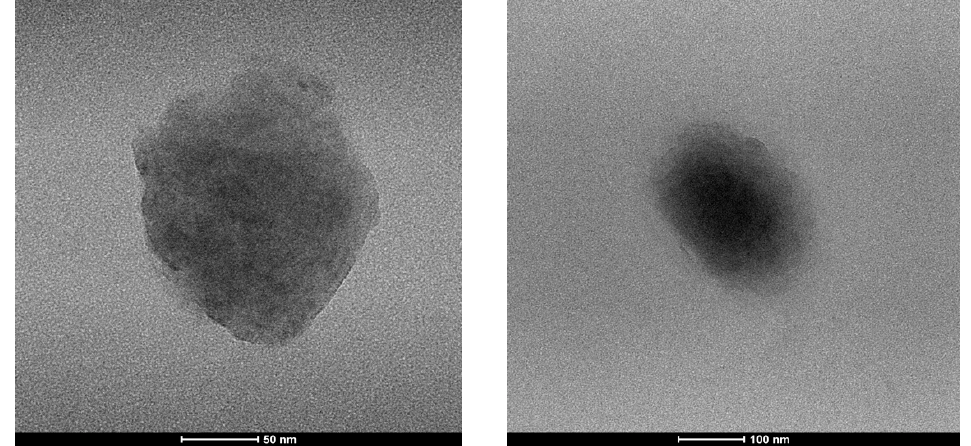
Figure 3. Morphology of CUR-HA-palmitate nanoparticles measured using transmission electron microscopy (TEM).